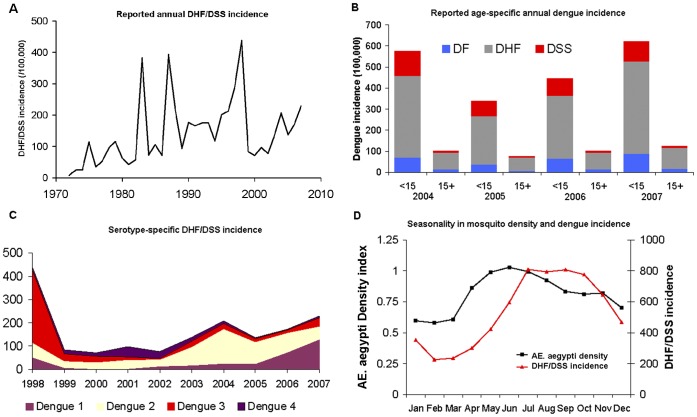
Results of dengue surveillance in Southern Vietnam.a. Reported DHF incidence from 1972 to 2007 (per 100,000 inhabitants). b. Reported dengue incidence for <15 years old and 15+ years old individual per level of severity (per 100,000 inhabitants) c. based on reported incidence and serotype distribution of isolated virus (about 1% of reported cases are subject to virus isolation) d. Seasonality in vector (Aedes Aegypti) density and monthly DHF incidence. Seasonality was assessed through locally weighted scatterplot smoothing [61]. Data derived from the surveillance system of dengue in Southern Vietnam coordinated by the Pasteur Institute in Ho Chi Minh.